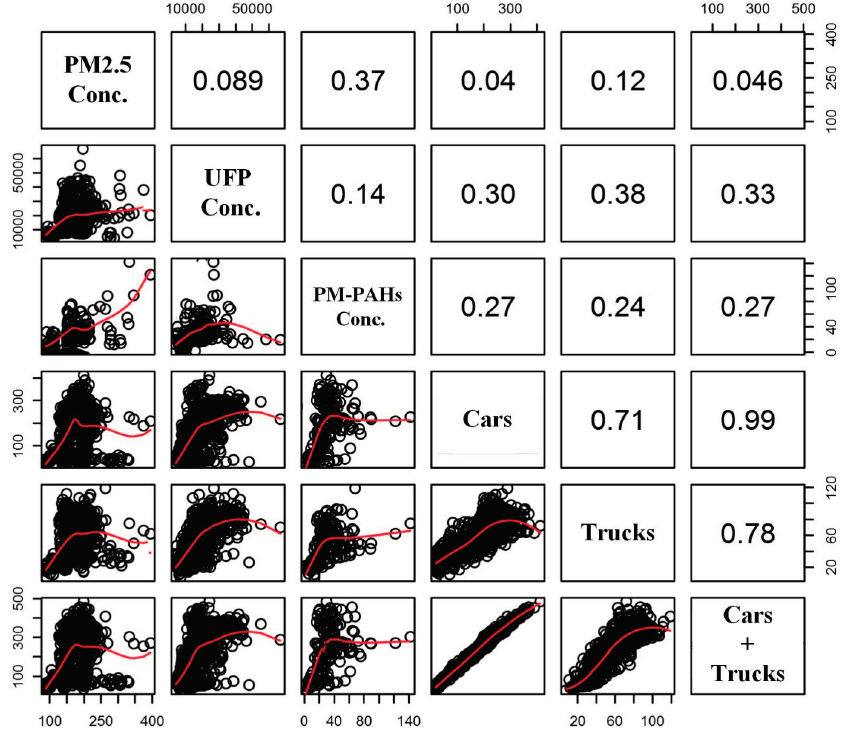
Figure 5. Inter-correlation between the vehicle data and pollution measured in the police station. The upper right corner shows the coefficient of determination and the red lines in the lower left corner represent loess